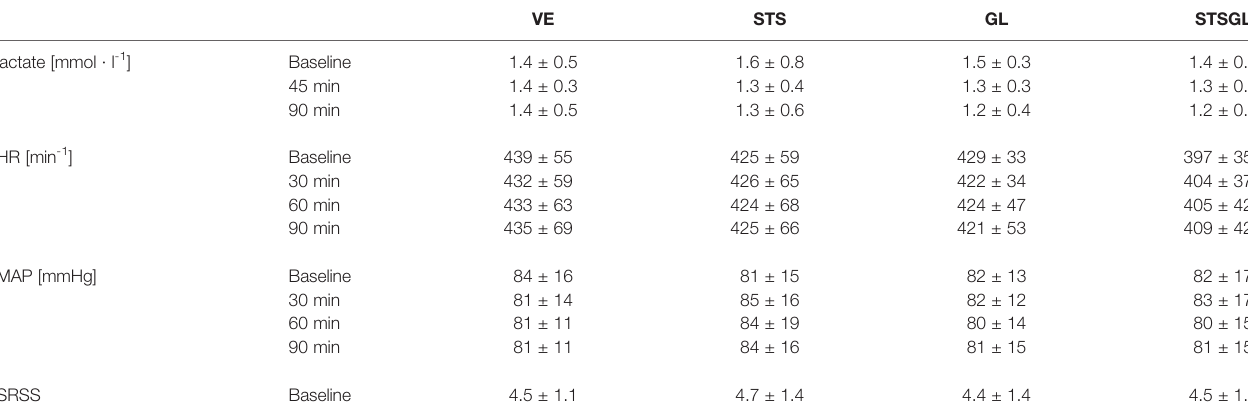
TABLE 1 | Physiological data and SRSS.